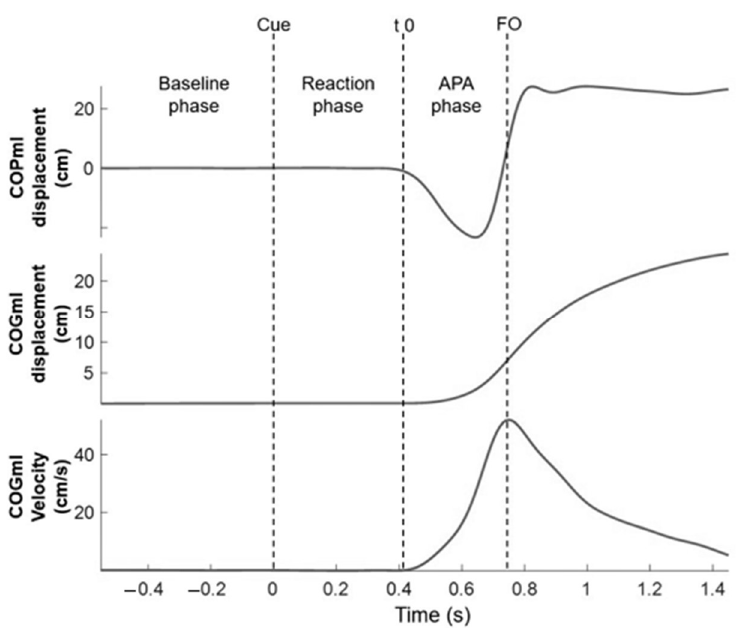
Figure 2. Representative trial showing the displacement of COP, and displacement and velocity of the center of gravity (COG) in the mediolateral direction. The events and phases are marked as follows. Cue: presentation of the auditory cue; t0: onset variation in the medial–lateral COP (COPml) from the baseline; FO: lifting foot off the ground (FO); baseline phase: 500 ms period prior to cue; reaction phase: time from cue to t0; and APA phase: time from t0 to FO.